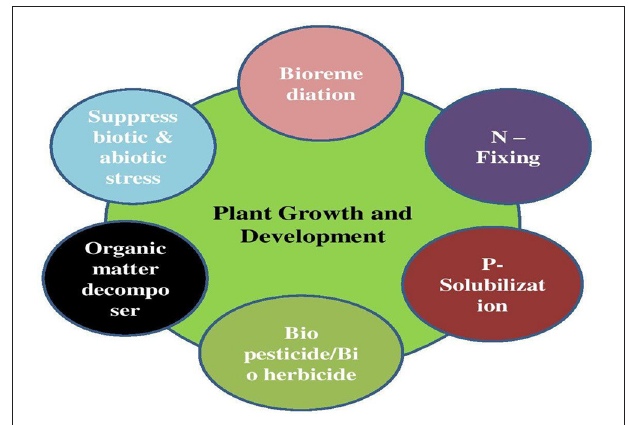
FIGURE 2 | Role of the microbiome in sustainable